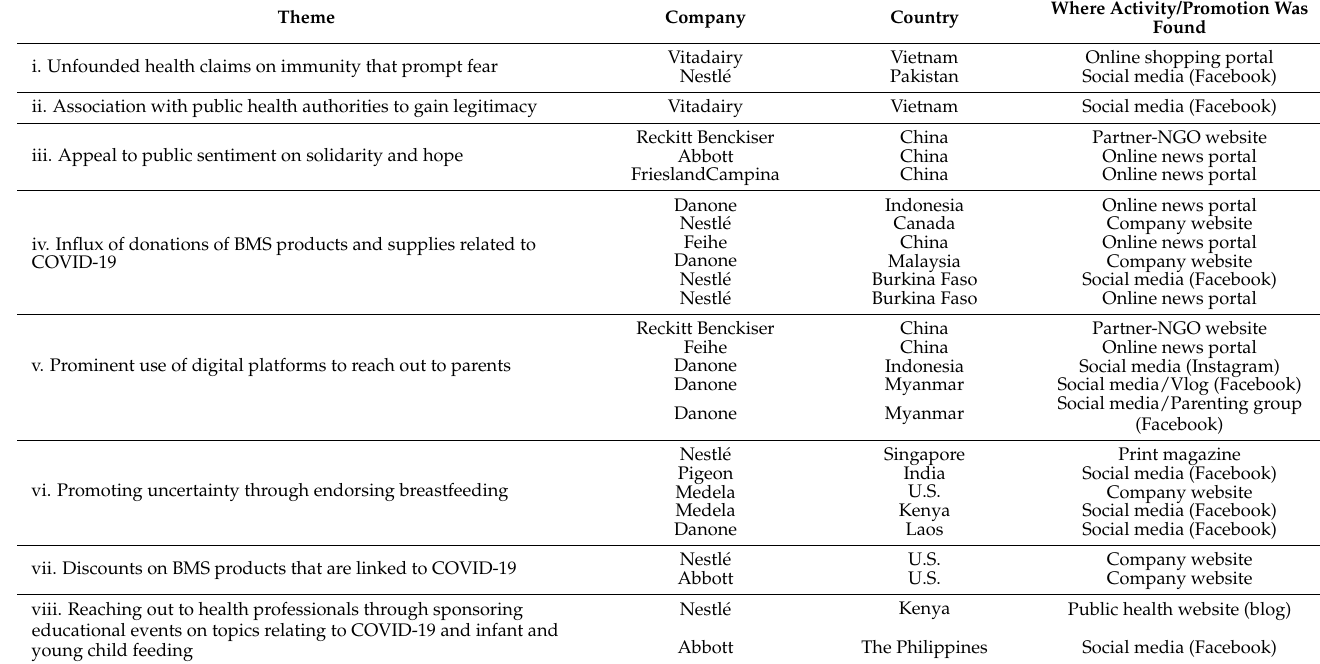
Table 1. Summary of marketing themes, companies, countries, and where promotion was